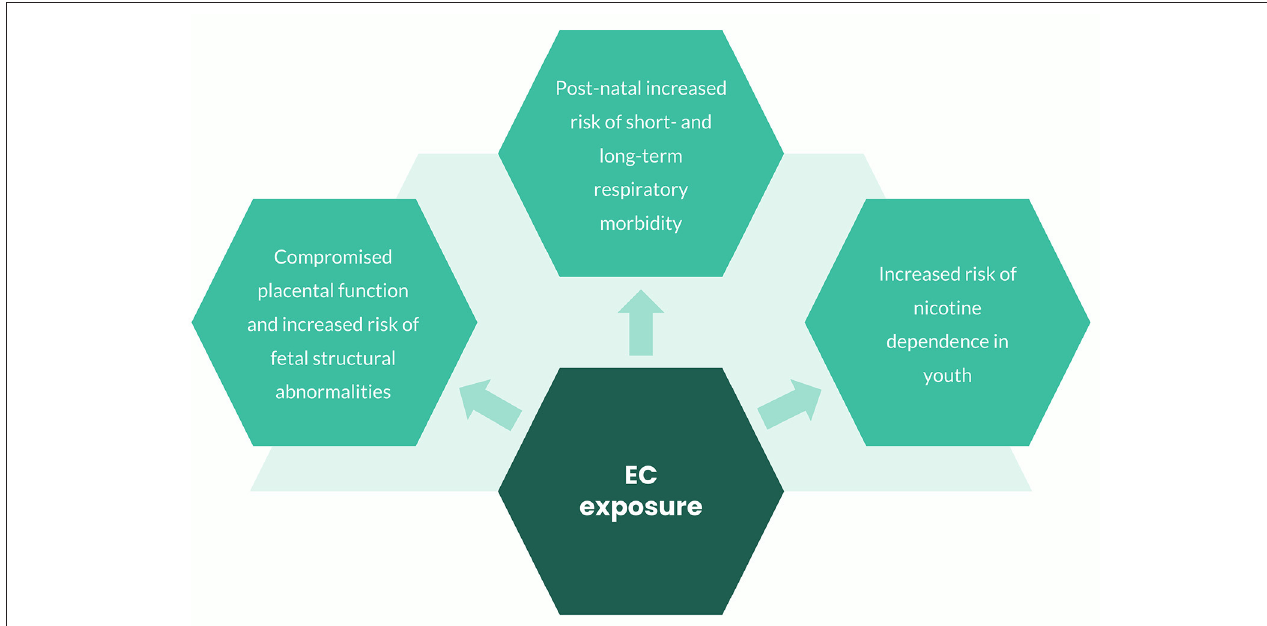
FIGURE 1 | Effects related to EC exposure throughout different vulnerability